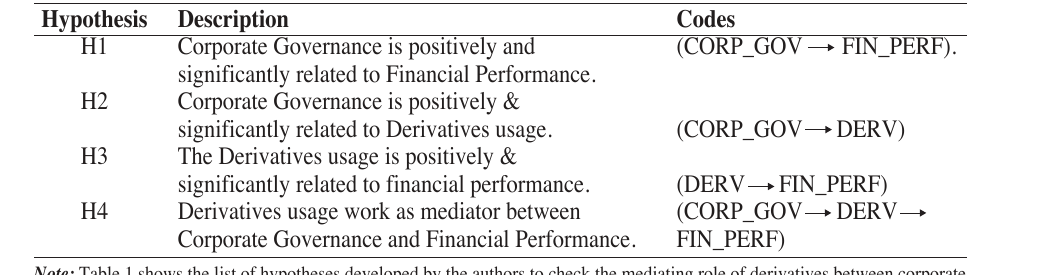
Table 1: List of